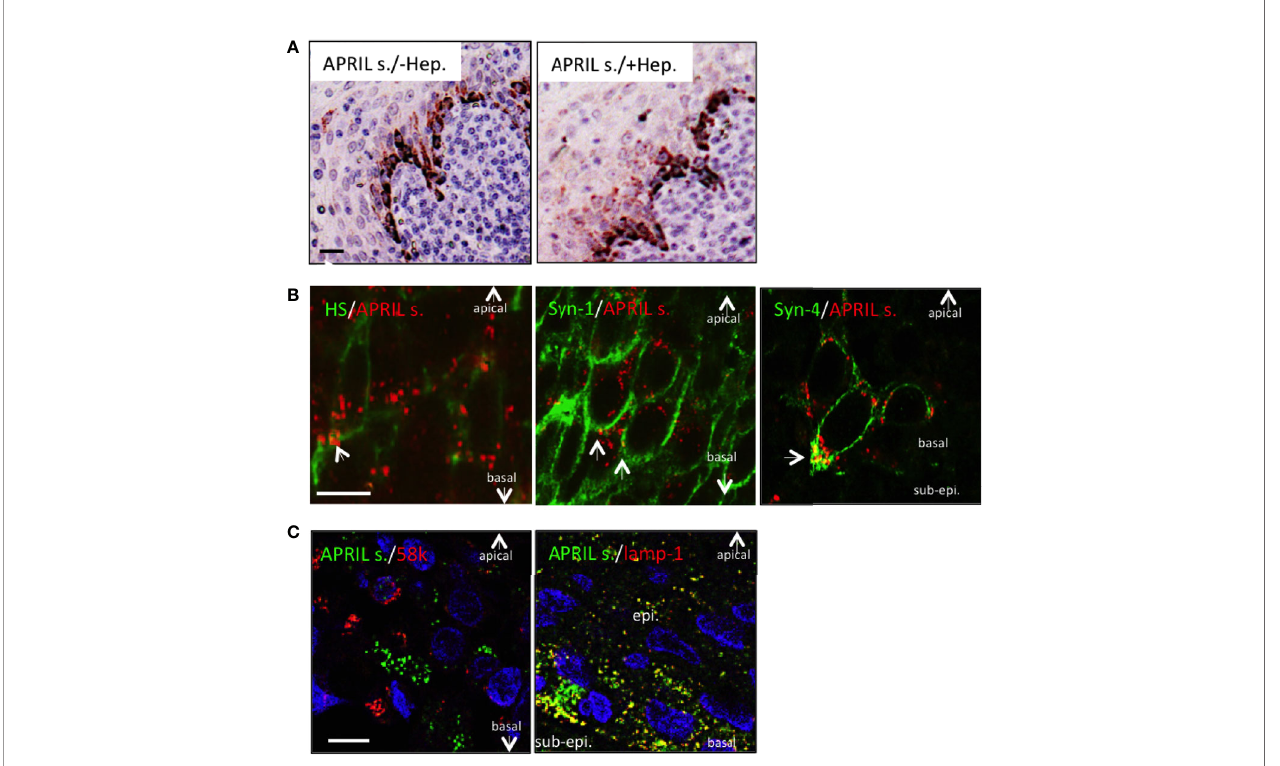
FIGURE 3 | Processed APRIL accumulates in LAMP-1+ vesicles in the basal layer. (A) Serial sections of tonsils were stained for secreted APRIL in the absence or presence of heparitinase treatment. Scale bar = 20 µm. Results are representative of three tonsillectomies. (B) Secreted APRIL (red) was costained with syndecan- 1/-4 and native HS (all green). Arrows show colocalization of secreted APRIL with HS/syndecan-1/syndecan-4. Scale bar = 5 µm. Results are representative of 10 tonsillectomies. (C) Secreted APRIL (green) was costained with Golgi (58k, red) and exosome (Lamp-1, green) markers. Scale bar = 10 µm. Surface epithelia are shown with the apical, basal, and sub-epithelium (sub-epi.) localizations marked. In some experiments, nuclear staining (DAPI) is shown. Patients with recurrent infections were used. Results are representative of 10